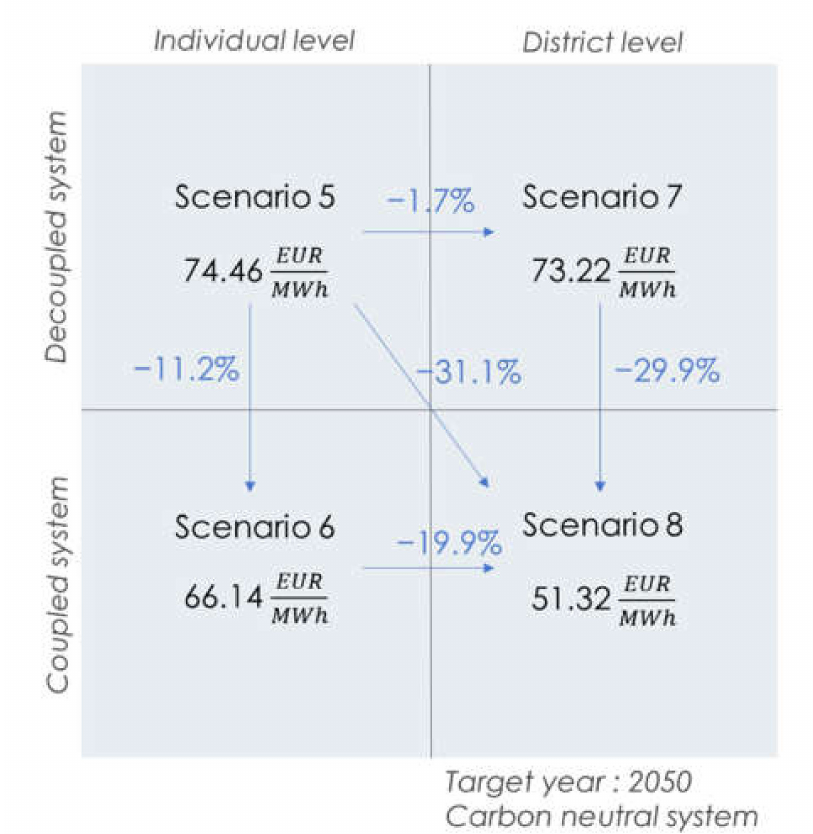
Figure 4. LCOE comparison for scenarios 5 to 8 of the case